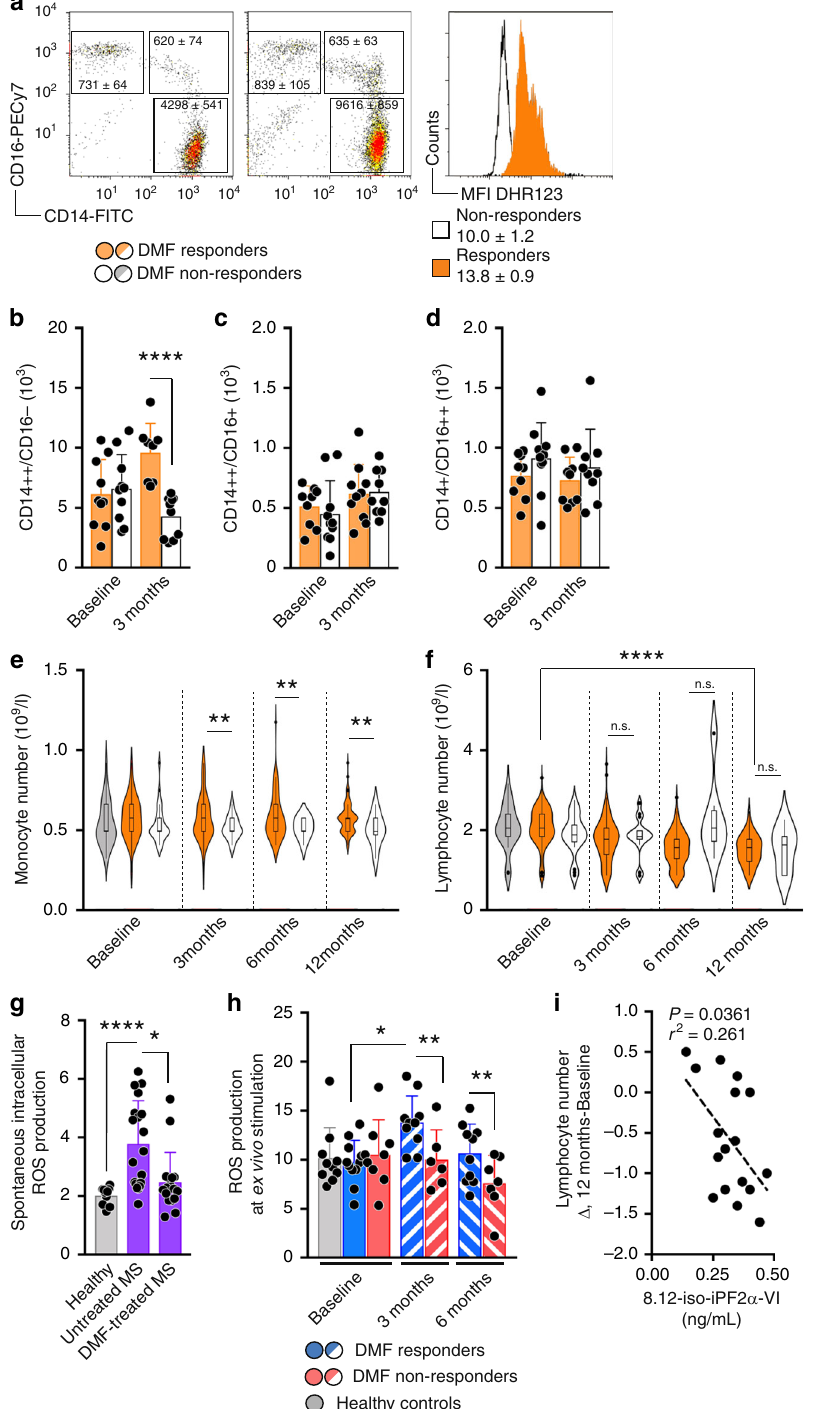
Fig. 2 Monocyte numbers and ROS generation separate DMF responders from non-responders. a Representative plots for gating strategy of monocyte subsets stating mean ± S.E.M. at three months. Histogram shows representative DHR-123 MFI ± S.E.M. at 3 months. b – d Number of monocyte subsets in DMF responders ( n = 10) and non-responders ( n = 10) at baseline and at three months. e Violin with box-and-whisker plots indicating values outside the 5 – 95 percentile are indicated as dots of monocytes and ( f ) lymphocytes from healthy controls ( n = 28), DMF responders ( n = 171) and DMF non- responders ( n = 26) over time. g Spontaneous generation of ROS in healthy controls ( n = 10) and DMF untreated ( n = 18) and treated ( n = 18) patients. h ROS generation in ex vivo -stimulated monocytes from DMF responders ( n = 10) and non-responders ( n = 7) measured with DHR-123. i Correlation between Δ lymphocyte number and 8.12-iso-iPF2 α -VI-isoprostanes at 6 months determined with Spearman ’ s correlation ( n = 17). Graph ( b – d , g , h ) shows mean and S.D. Analysis in ( f ) was performed with ANOVA for linear trend over time and ( e ) to test mean comparison between responders and non- responders at every timepoint. Remaining analysis between paired patients were performed with paired t test whereas analysis between healthy controls and patients or between patient groups were performed with Student ’ s two-tailed t test. * P < 0.05, ** P < 0.01, *** P < 0.001, **** P <